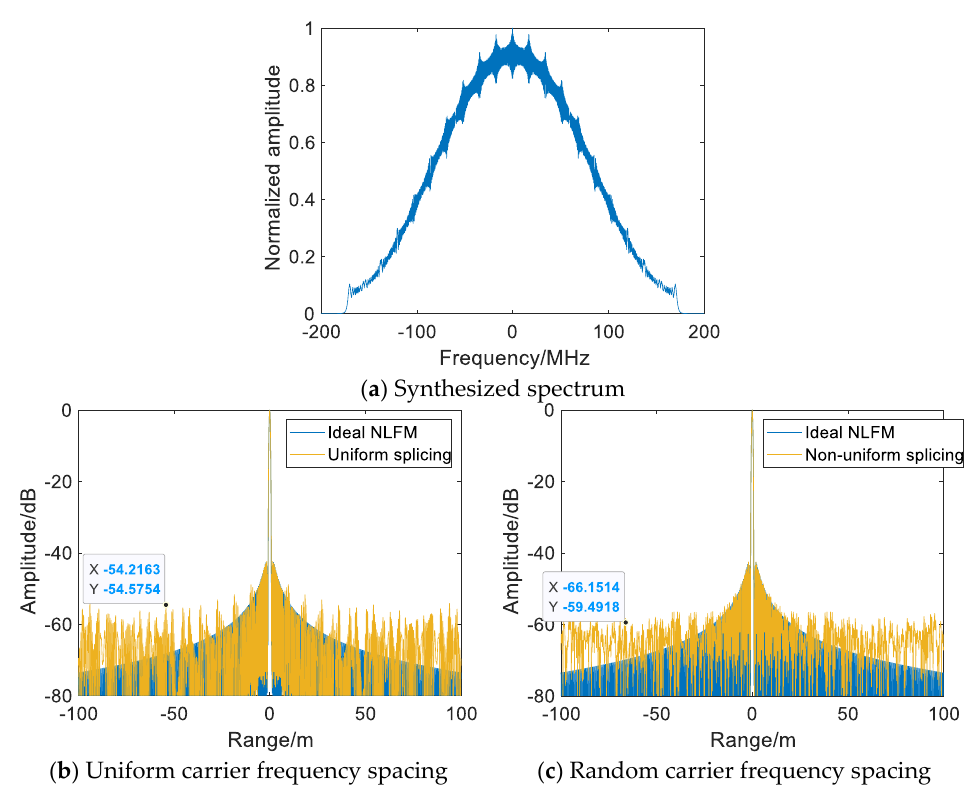
Figure 8. Range-compressed NLFM SWW after spectral correction ( 𝑁 = 20 𝐵 = 20.7 MHz 𝛥𝑓 = 17.2 MHz 𝑇 𝑠𝑦𝑛 = 145 us ). Table 1. Performance indicator of range-compressed NLFM